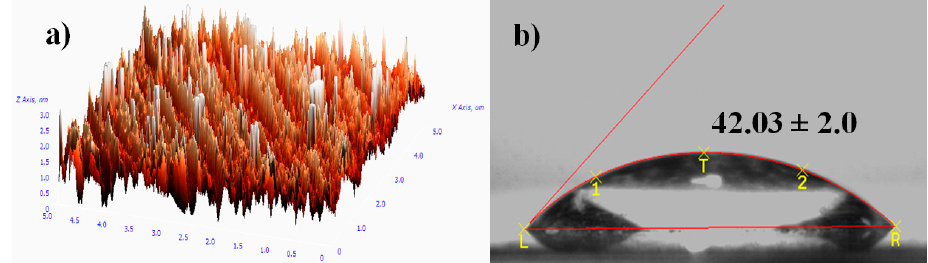
Figure 3. Analyses formation of PEG silane monolayer by ( a ) atomic force microscopy (AFM) image (size images: 7 × 7 µm²) ( Z -range: 30 nm) and ( b ) optical image of contact angle.